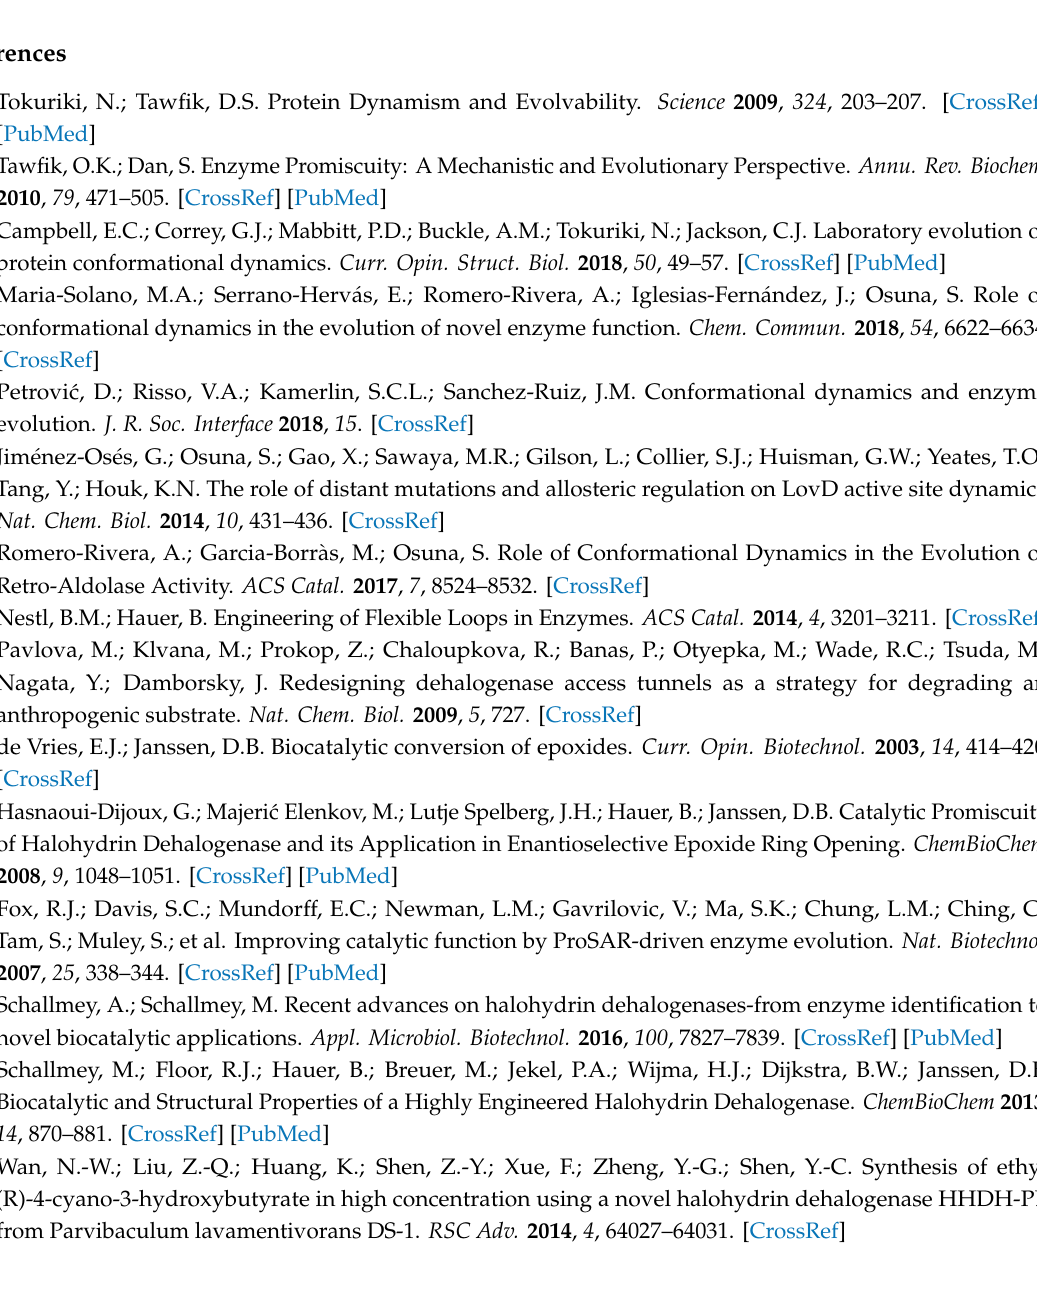
Figure S1: tSNE and HDBSCAN representations, Figure S2: T1 representation as tetramer, Figures S3–S7: Random Forest Classifier for HheA2, HheB, HheC, HheD2, and HheG, Figure S8: Most important contacts computed using Random Forest